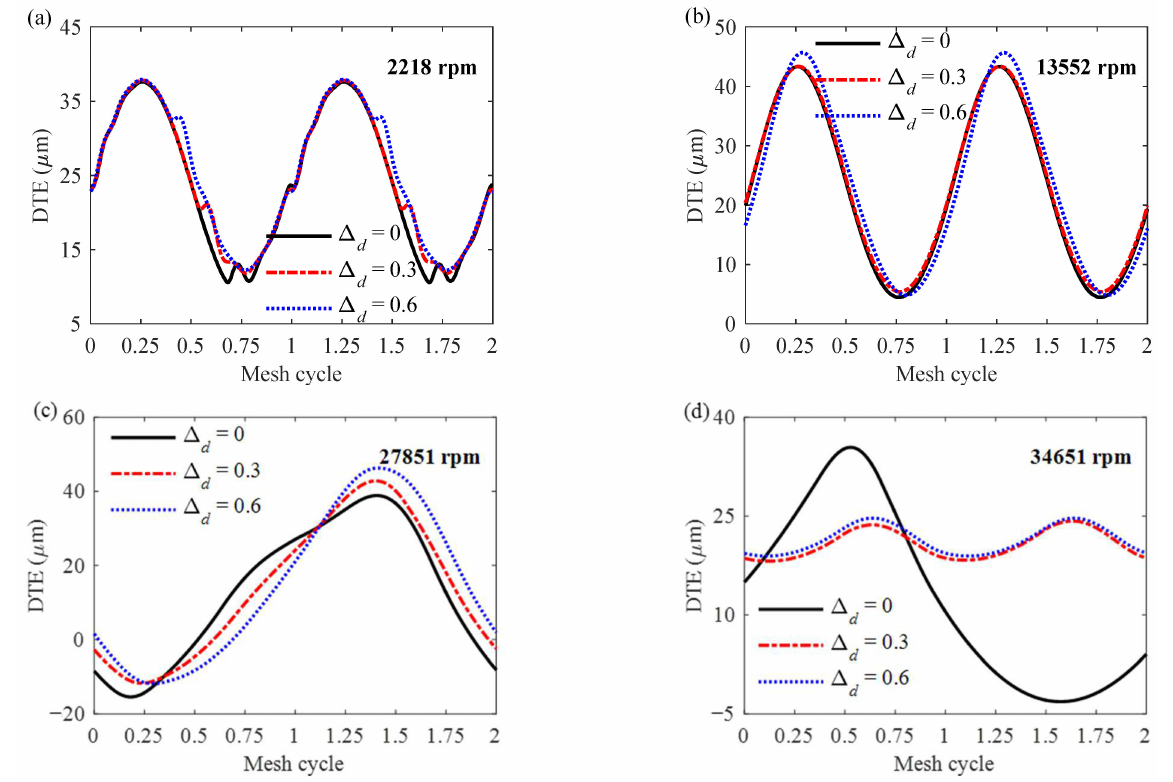
Figure 10. The DTE of the gear pair at different speeds in time domain ( a – d